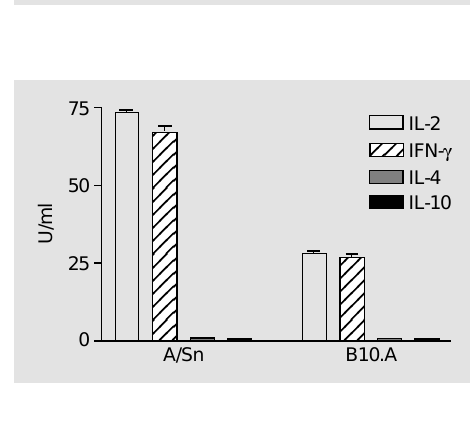
Figure 3 - Proliferation of im- mune T cells from A/Sn (A) and B10.A (B) mice stimulated with gp43 (10 µg/ml) in the presence of increasing concentrations of syngeneic dendritic cells (squares) or macrophages (tri- angles). Results are representa- tive of three independent experi- ments and are reported as arith- metic means ± SD. APC, Anti- gen-presenting